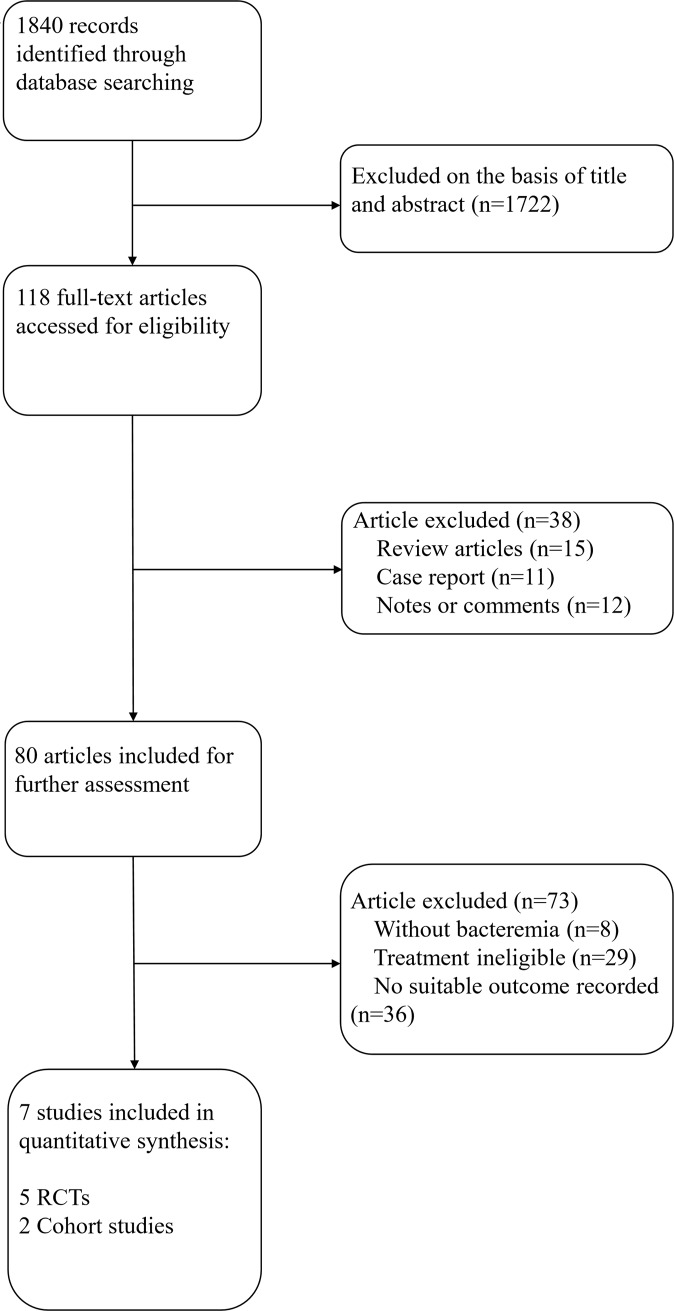
Flowchart and study selection.